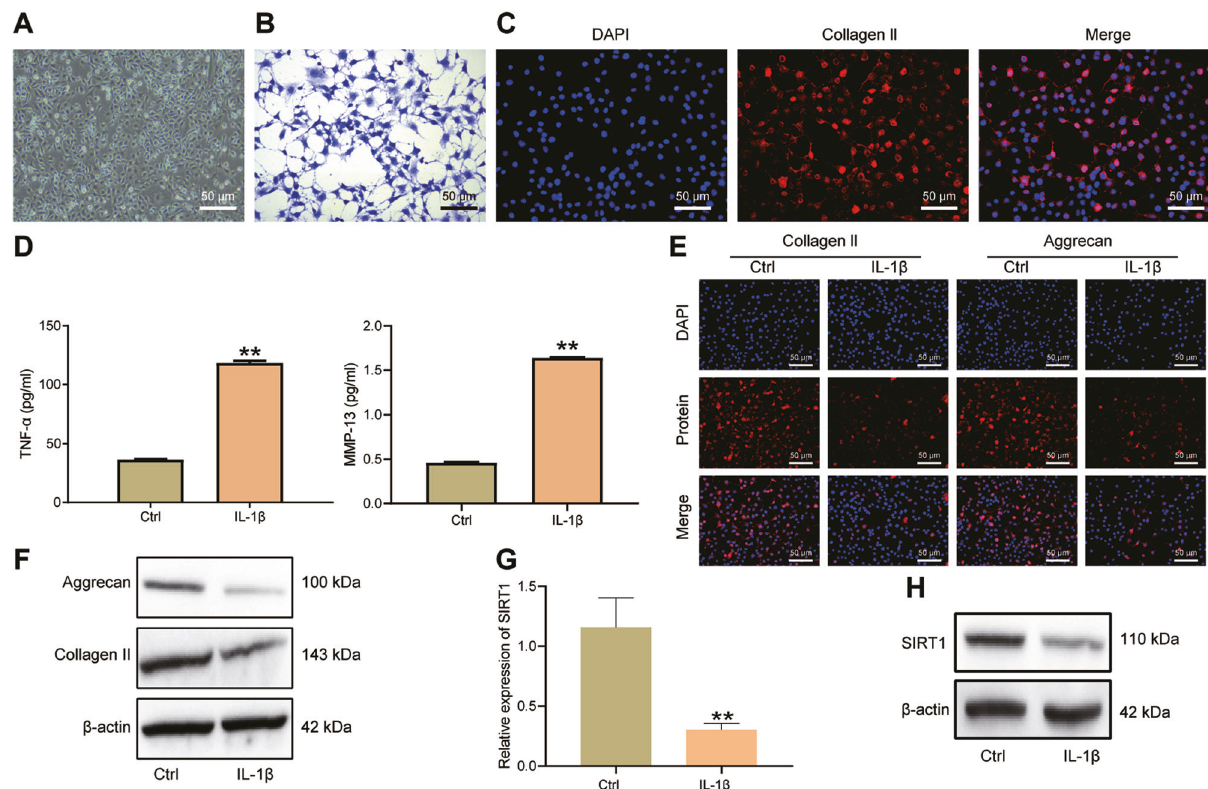
Fig. 3 Characterization of SIRT1 expression in IL-1 β -stimulated chondrocytes in vitro. A Microscopic image of primary human chondrocytes. B Toluidine blue staining to detect Proteoglacan expression in human chondrocytes in response to IL-1 β stimulation. C Immuno fl uorescence staining assay to detect Collagen II expression (red fl uorescence) in human chondrocytes in response to IL-1 β stimulation. D ELISA to detect TNF- α and MMP-13 in the cell supernatant of primary human chondrocytes in response to IL-1 β stimulation. E Immuno fl uorescence staining for the expression of Aggrecan and Collagen II in human chondrocytes in response to IL-1 β stimulation. F Western blot for the protein expression of Collagen II and Aggrecan in primary human chondrocytes in response to IL-1 β stimulation. G qRT-PCR detection of SIRT1 in primary human chondrocytes in response to IL-1 β stimulation. H Western blot detection of SIRT1 protein expression in primary human chondrocytes in response to IL-1 β stimulation. ** p < 0.01 compared with Ctrl group. Cell experiments were performed in